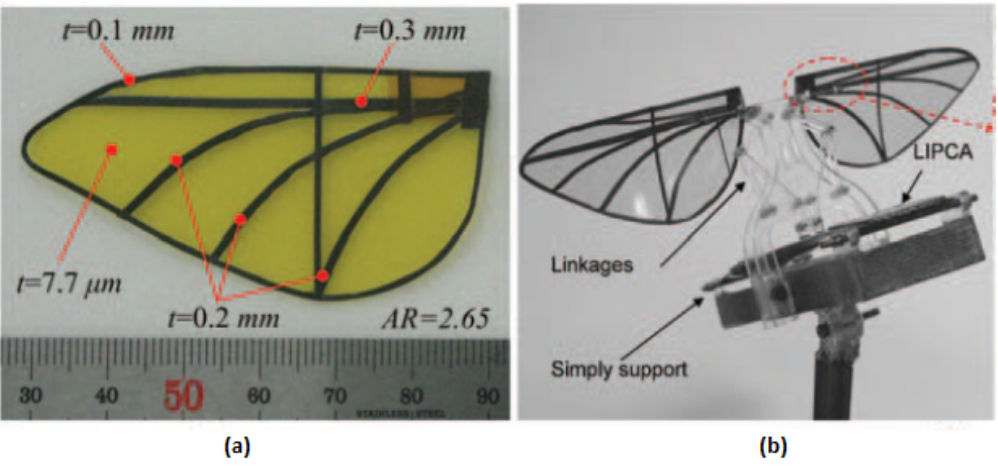
Figure 9. ( a ) Artificial Hawkmoth wing; ( b ) Fully assembled flapping system